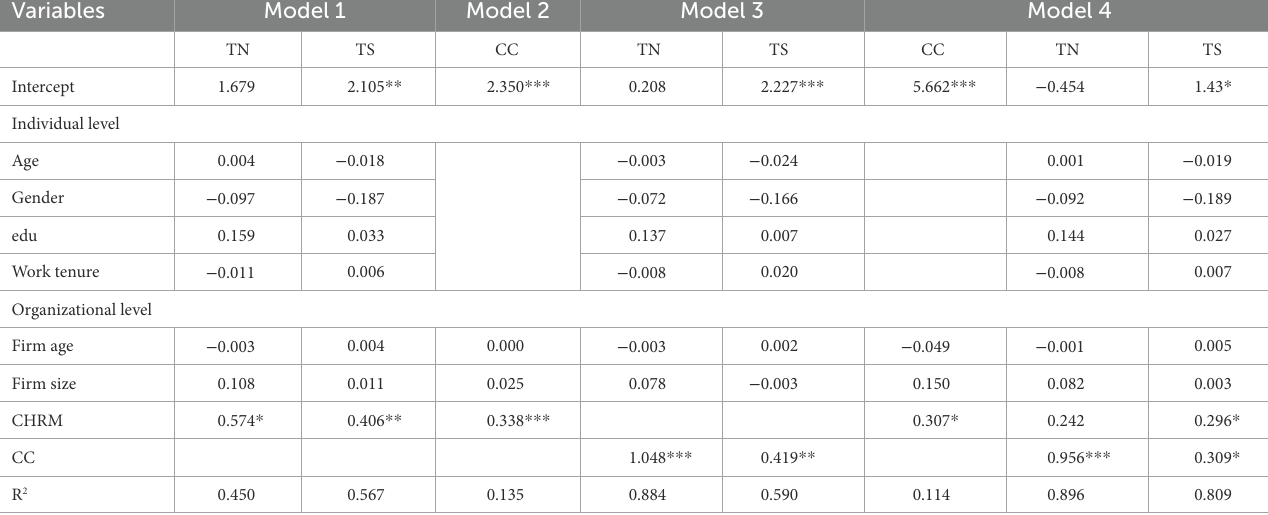
TABLE 5 The model